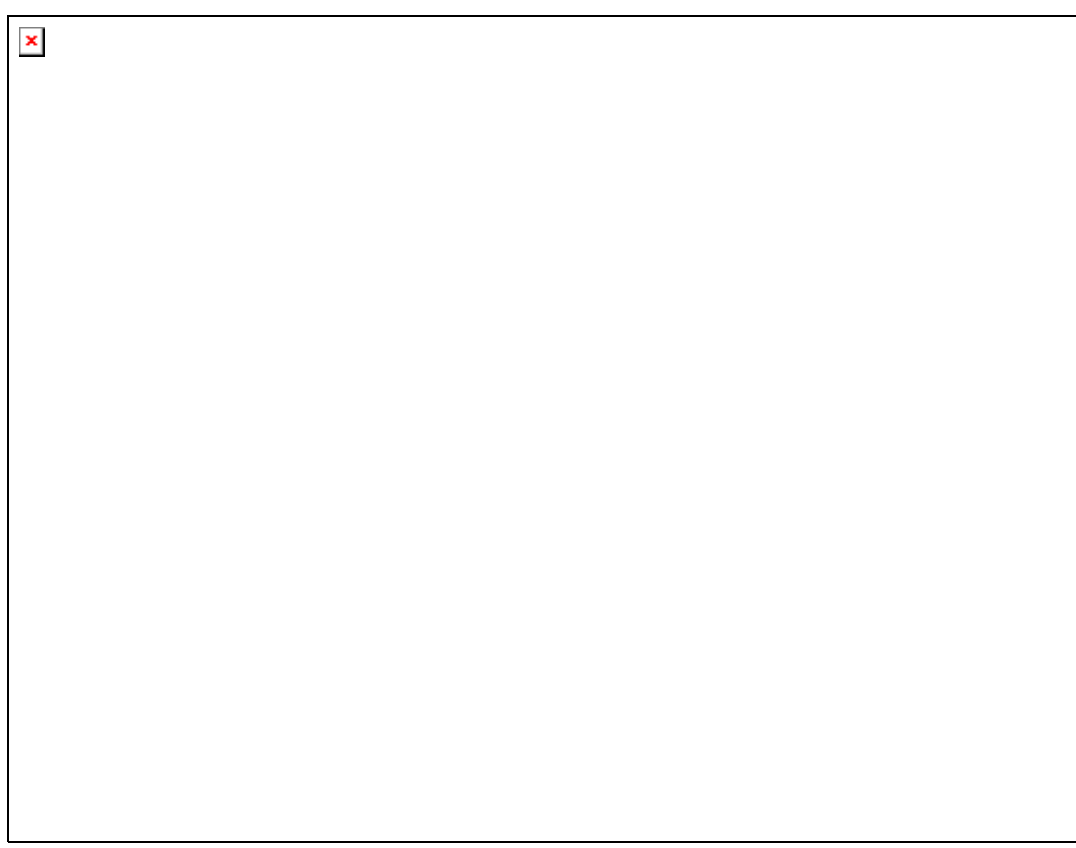
Figure 1. Locations of watersheds and primary gauging stations used in the study (Gauging station locations are only shown for test